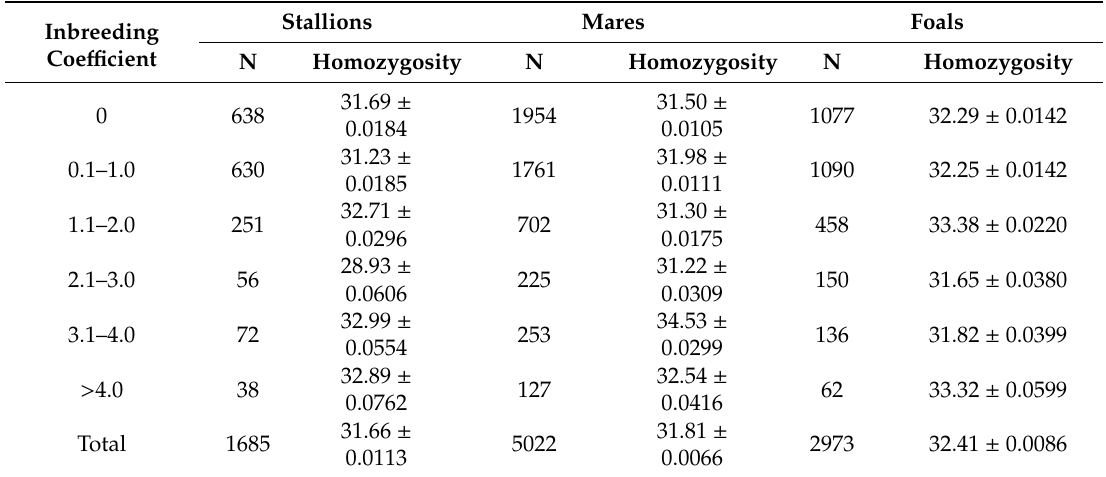
Table 6. The inbreeding coe ffi cient (Fx) and homozygosity level in groups of TB horses.